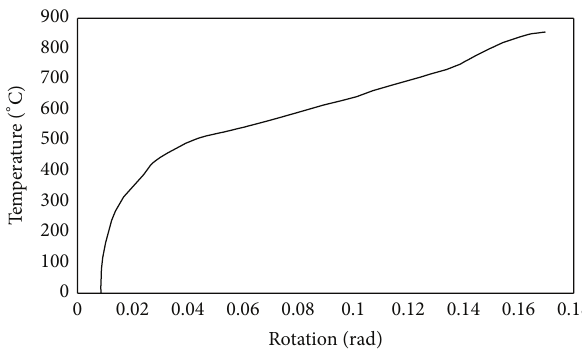
Figure 23: Diagram of stiffness: temperature for the connection with the end